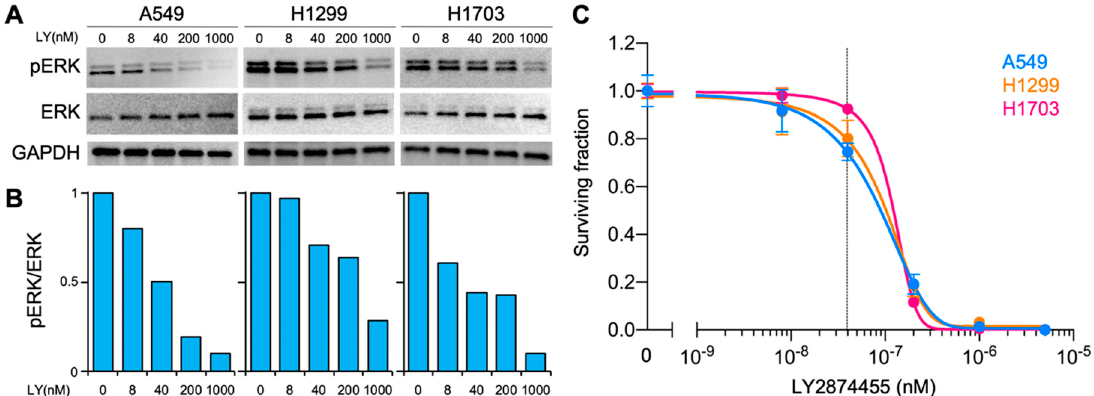
Figure 3. Concentration-dependent effect of LY2874455 (LY). A , Immunoblots showing suppression of phosphorylation of extracellular signal-regulated kinase (ERK). Cells were exposed to LY for 1 h before collection. pERK, phosphorylated ERK. B , Quantitation of immunoblots shown in A. The ratio of pERK to total ERK is shown relative to untreated controls and normalized to GAPDH. C , Clonogenic survival of cells treated by LY28744554 alone. Dashed line indicates 40 nM.